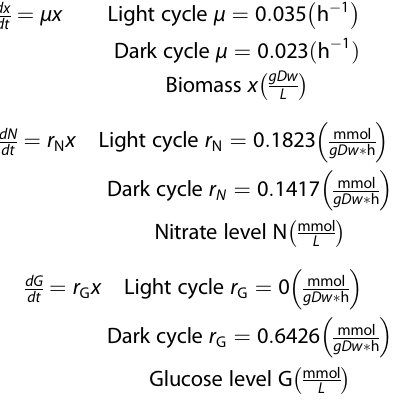
Summary of equations for 2L bioreactor